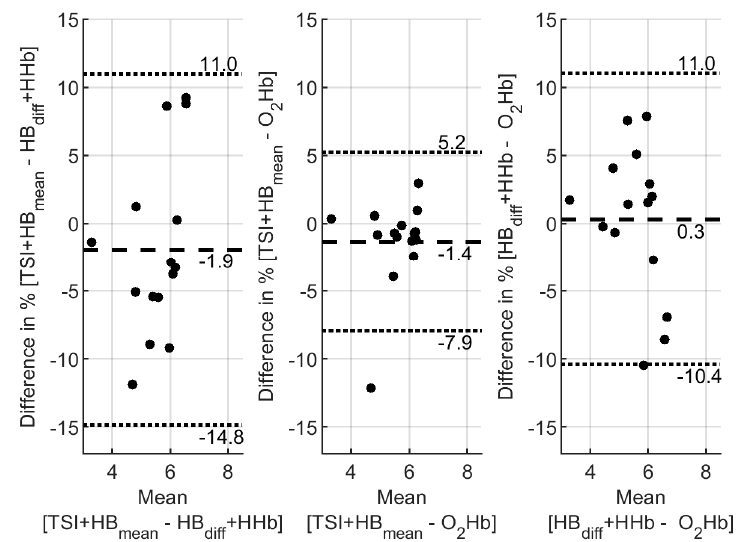
Figure 5. Bland–Altman plots. Left plot: comparison of TSI + HBmean and HBdiff + HHb. Middle plot: comparison of TSI + HBmean and O 2 Hb. Right plot: comparison of HBdiff + HB and O 2 Hb. Note: dashed horizontal line represents the bias [%] and dotted horizontal line represents the limits of agreement (±1.96 SD) of the respective comparison. For parameters with a plus sign (e.g., TSI + HBmean), the mean value was calculated because statistics showed no significant differences between those parameters. Table 2. Results of the Bland–Altman plots comparing the different methods. Bias [%] TSI and Hbmean—Hbdiff and Range [%]